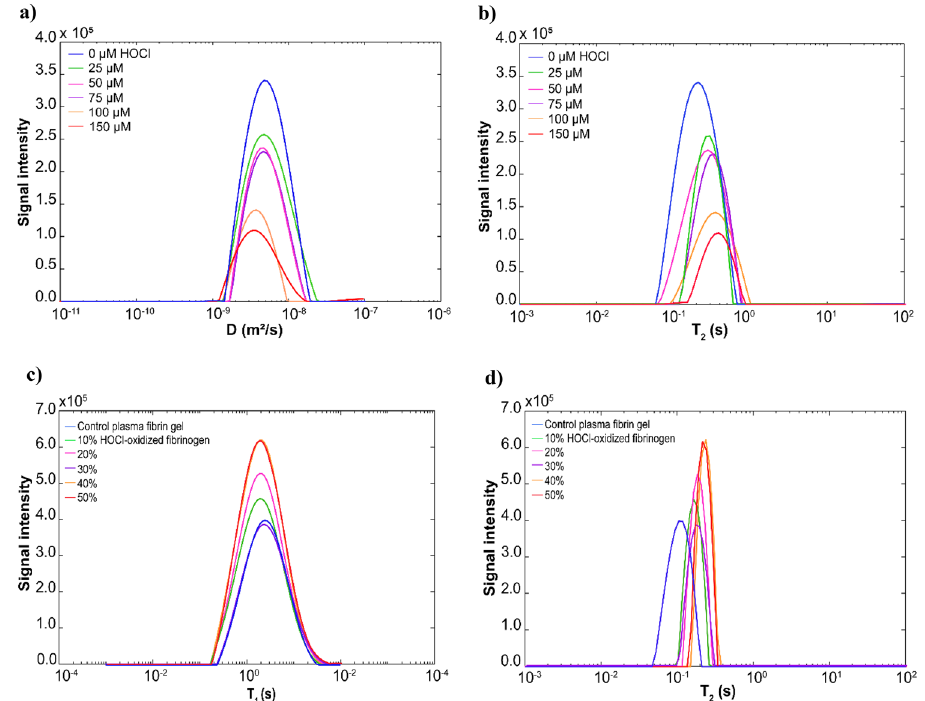
Figure 3. ( a ) Diffusion coefficient (D) distributions of bulk water in the control fibrin gel and fibrin gels oxidized by increasing HOCl concentrations. ( b ) T 2 distributions of bulk water in the control fibrin gel and fibrin gels oxidized by increasing HOCl concentrations. Diffusion/T 2 correlations of water protons in the fibrin gels oxidized by increasing HOCl concentrations (25, 50, 75, 100, 150 µM). The D/T 2 correlations were simultaneously measured by PFG for diffusion coefficient (D) and conventional CPMG for T 2 relaxation time. Fibrin gel without HOCl oxidation (0 µM HOCl) was used as a control. ( c ) T 1 distributions of bulk water in the control plasma fibrin gel and plasma fibrin gels formed by adding an increasing percentage of HOCl-oxidized fibrinogen (10, 20, 30, 40, 50%). ( d ) T 2 distributions of bulk water in the control plasma fibrin gel and plasma fibrin gels formed by adding an increasing percentage of HOCl-oxidized fibrinogen. Plasma fibrin gel without HOCl-oxidized fibrinogen (0%) was used as a control. Plasma fibrin gels were indirectly oxidized by adding HOCl-oxidized fibrinogen (10, 20, 30, 40, 50%) to plasma prior to clotting. The HOCl-oxidized plasma fibrin gels were formed by adding HOCl-oxidized fibrinogen and then incubated with 0.16 NIH U/mL thrombin at 37 °C for 1 h. The T 1 /T 2 correlations were simultaneously measured by saturation inversion recovery for T 1 time and conventional CPMG for T 2 relaxation